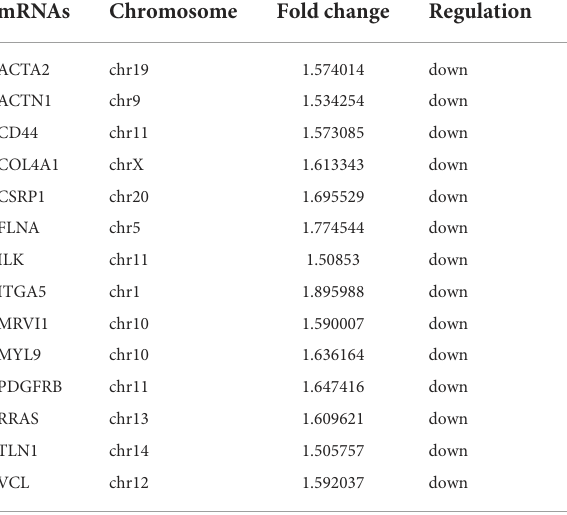
TABLE 4 Concerned differentially expressed mRNAs. TABLE 5 Concerned differentially expressed lncRNAs screened through analysis of mRNA-lncRNA co-expression